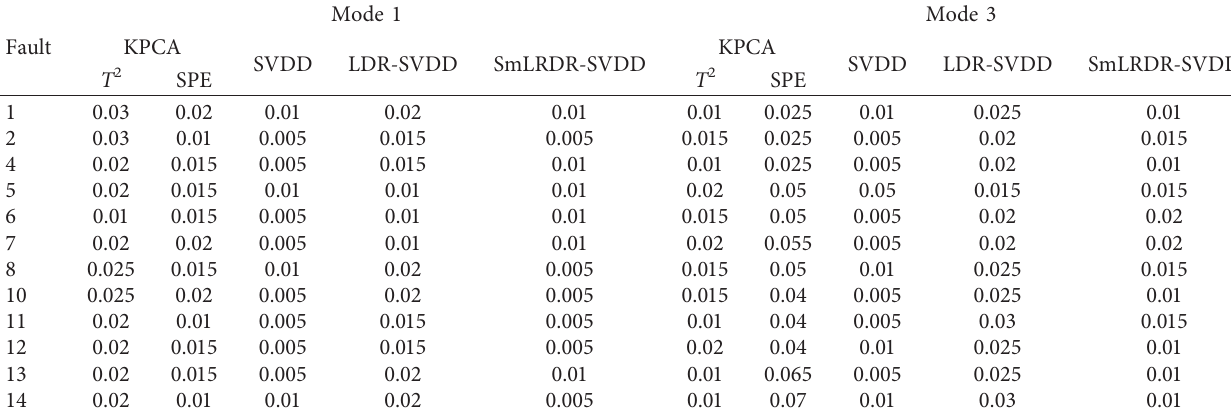
Table 4: FAR for all test conditions on TE process.